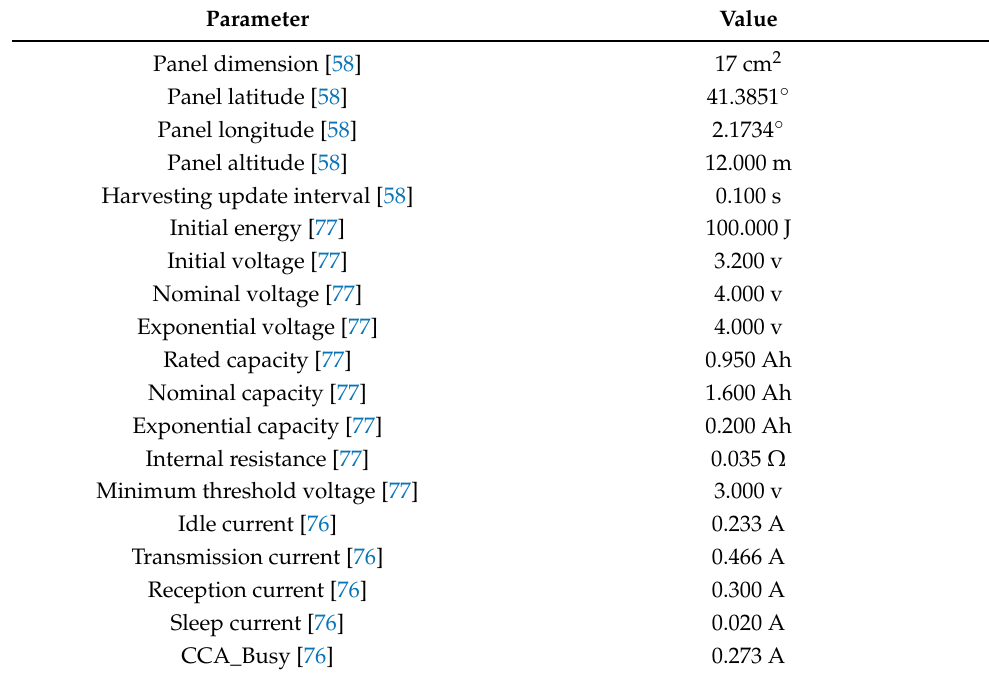
Table 7. Energy-related